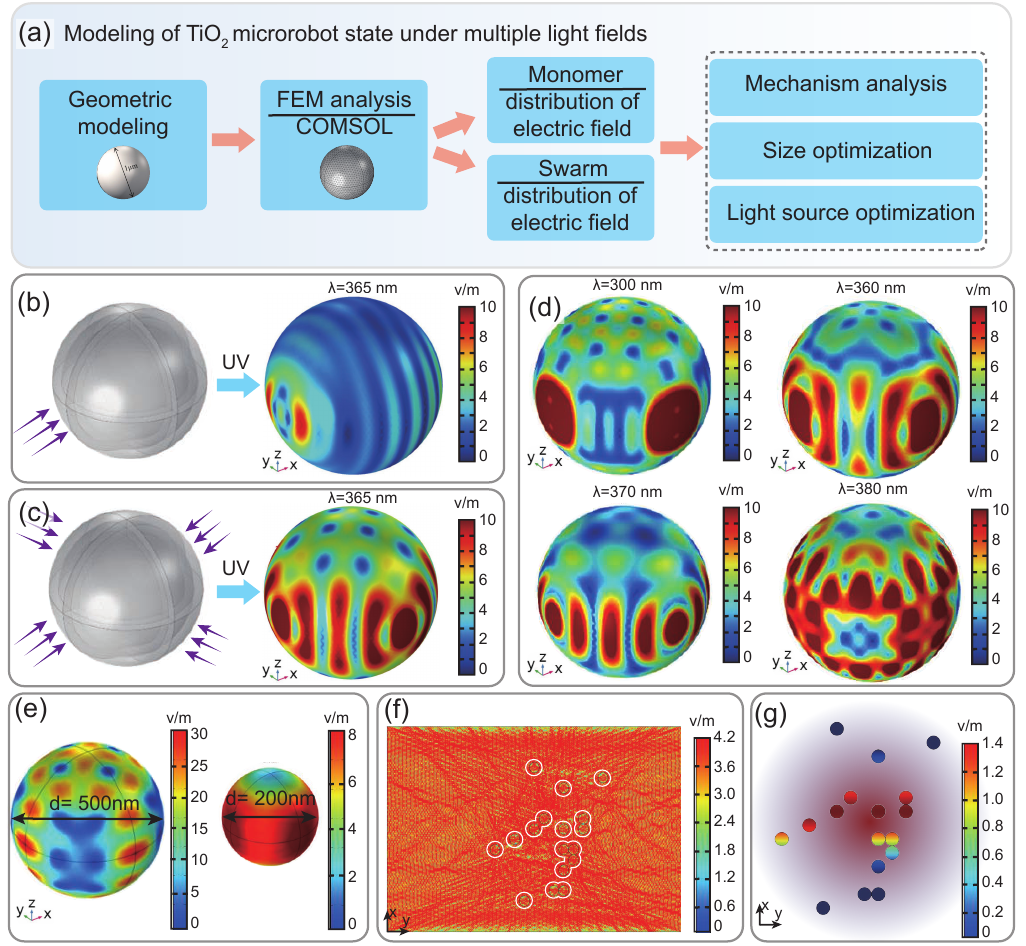
Figure 2. Modeling of TiO 2 microrobot motion state under multiple light fields. ( a ) The process of simulating and optimizing the design and driving strategy of the TiO 2 microrobot that based on the finite element method. Electric field distribution within a TiO 2 microrobot when irradiated by a single ( b ) and multiple ( c ) light sources. ( d ) Electric field distribution within a microrobot induced by UV light with different wavelengths λ . ( e ) Electric field distribution around TiO 2 microrobots with different diameters under the same illumination conditions. ( f ) Electric field distribution around the TiO 2 microrobot swarm when irradiated by multiple light sources. ( g ) The electric field distributions inside the individual of the TiO 2 microrobot swarm under UV light